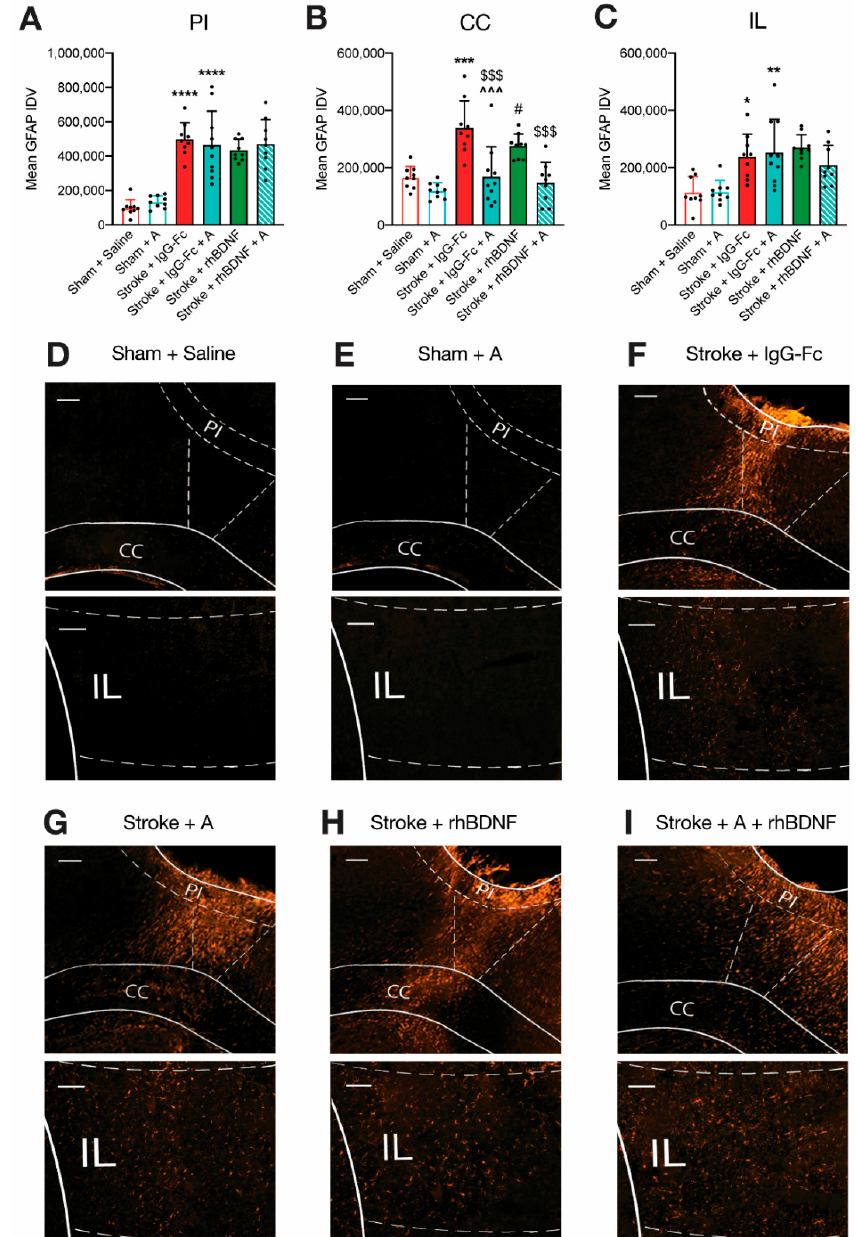
Figure 6. Effects of compound A treatment, with or without rhBDNF, on stroke-induced reactive astrogliosis. Bilateral strokes to the PFC induced a significant upregulation in the mean integrated density value (IDV) of GFAP+ve staining in the peri-infarct (PI, ( A )), corpus callosum (CC, ( B )) and infralimbic (IL, ( C )) regions of vehicle-treated animals (sham + saline, n = 9; stroke + IgG-Fc, n = 9). A similar stroke-induced upregulation in GFAP+ve expression was observed in the PI and IL regions of compound A-treated animals (sham, n = 9; stroke, n = 10). In contrast, compound A treatment, with ( n = 9) and without rhBDNF ( n = 8), appeared to dampen stroke-induced elevations in GFAP+ve expression within the CC. Representative micrographs of GFAP+ve staining are shown in ( D – I ). Two-way ANOVA: * p < 0.05, ** p < 0.01, *** p < 0.001, **** p < 0.0001, relative to saline-treated sham animals. ^^^ p < 0.001, relative to vehicle-treated stroke animals. # p < 0.05, relative to COMPOUND G + rhBDNF-treated stroke animals. $$$ p < 0.001, relative to vehicle-treated stroke animals. Scale bar (white bar, top left) = 100 μ m.